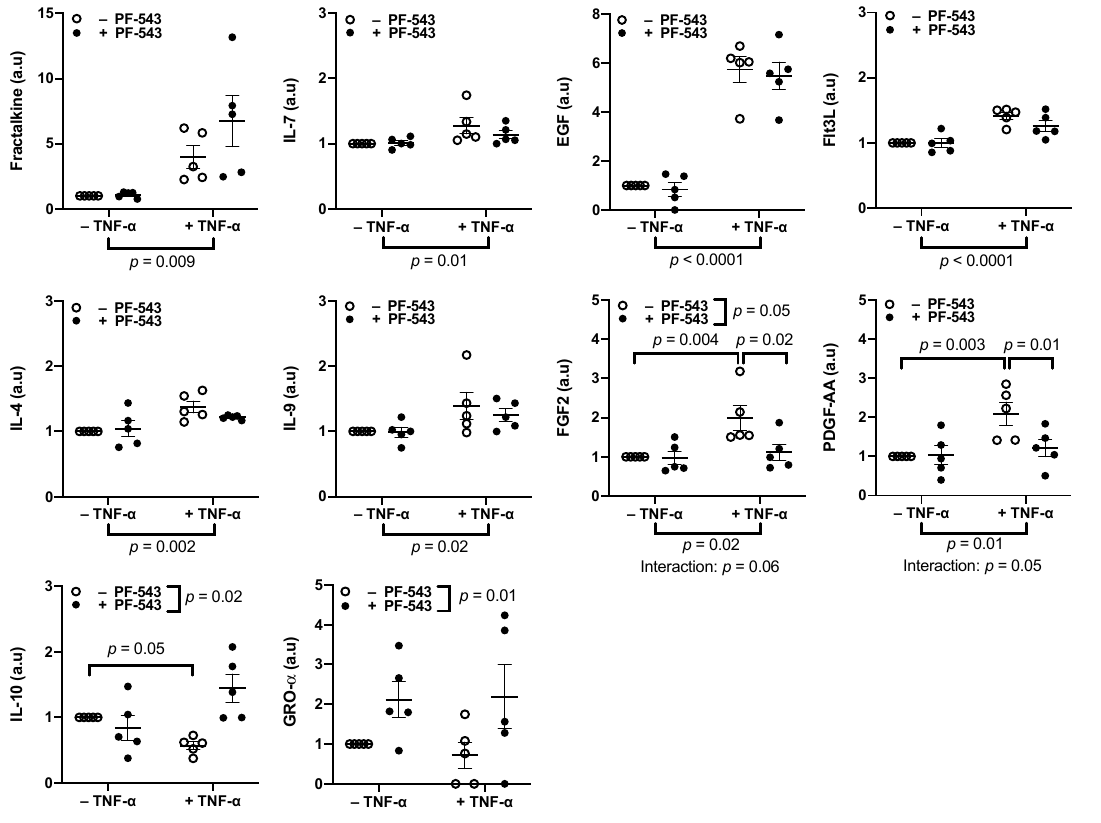
Figure 6. Inhibiting SphK1 with PF-543 diminished TNF- α effects on release of FGF2, PDGF-AA, and IL-10. Explants were pre-cultured for 4 days prior to treatment with 10 ng/mL of TNF- ɑ , 1 μ M PF-543, a co-treatment of both, or a no-treatment control, for 48 h. Supernatants were centrifuged at 15,000 RPM for 15 min prior to quantification of growth factors and chemokines using a multiplex array. Results were normalized against total protein mass, and normalized values were graphed as a ratio of change from the untreated control explant cultures. Results were analyzed by two-way ANOVA with the two-stage linear step-up procedure of Benjamini, Krieger, and Yekutieli post-hoc test. ( n = 5, Mean ± SEM) .